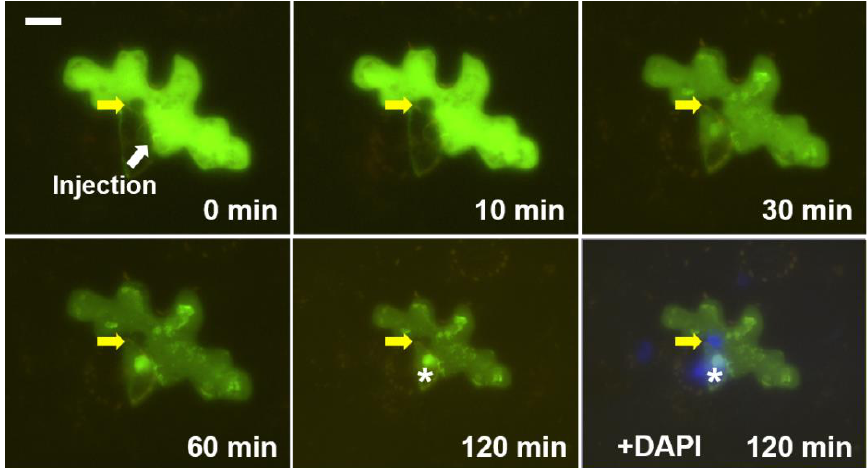
Figure 3. Example of microinjected cells showing no nuclear import of PSTVd despite of high level of cytosolic viroid injection: AF488-labeled PSTVd looks green, DAPI (blue) shows the nucleus, yellow arrows point the nucleus of the injected cell, asterisks (*) indicate the nucleus of the neighboring guard cell and the white scale bar is 20 µ m. These photos and similar images are also presented in Video S2.